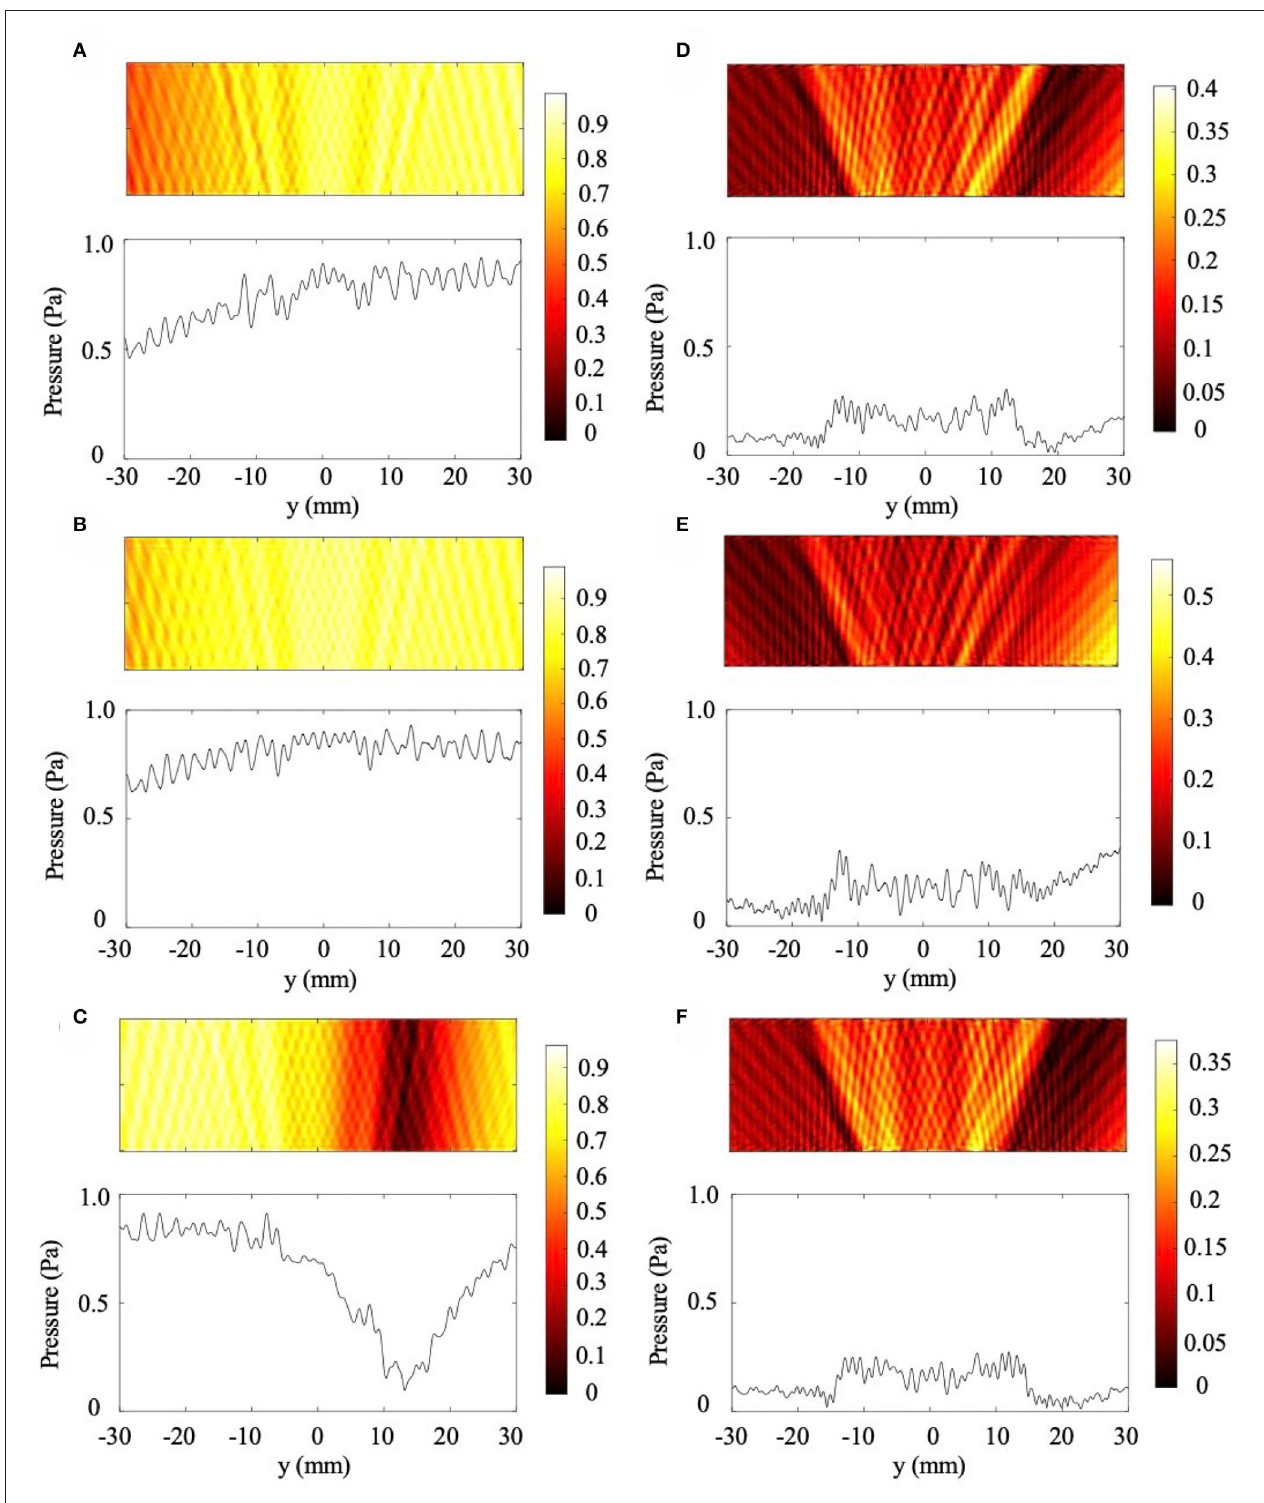
FIGURE 4 | Additional skull sloping cases. (A–C) are scattered pressure fields from skull thicknesses increasing by 0.5, 0.75, and 1.5mm, respectively, with a 10mm uniform NHCMM. (D–F) are corresponding 0.83% (0.5mm rise), 1.25% (0.75mm rise), and 2.5% (1.5mm rise) sloped cases with tuned NHCMM layers to match the skull thickness. The colorbars represent pressure amplitudes in